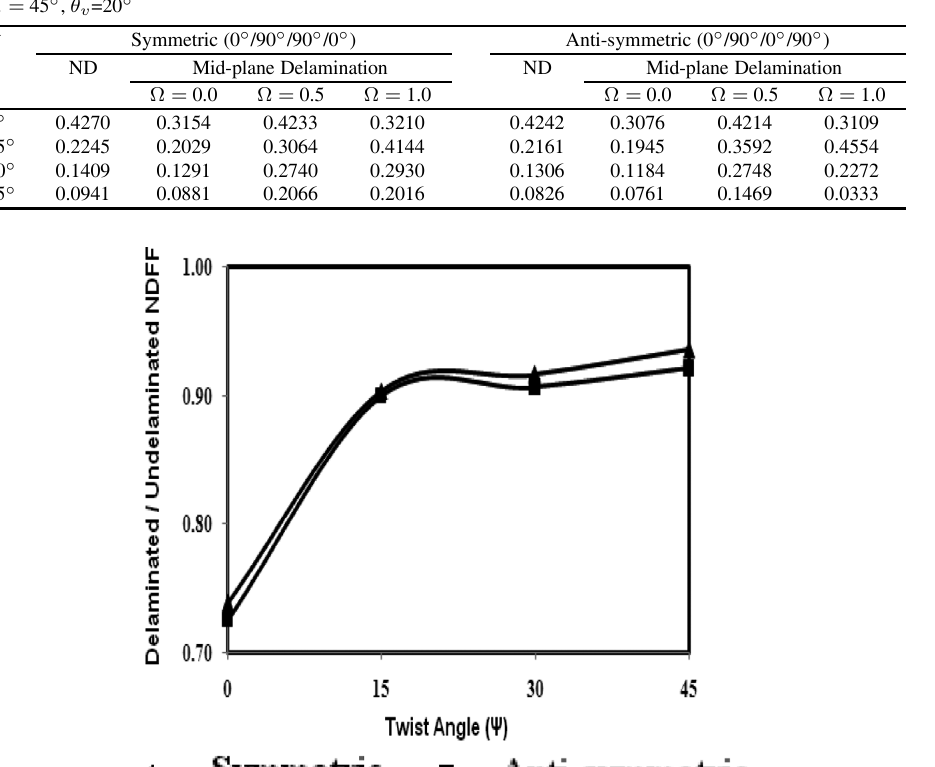
Fig. 5. Comparative representation of ratio of delaminated and undelaminated NDFF at stationary condition for symmetric and anti-symmetric four layered graphite-epoxy cross-ply composite pretwisted shallow conical shells, considering h = 0.0004, s/h = 1000, L/s = 0.7, d/L = 0.5, θ o = 45 ◦ , θ v = 20 ◦